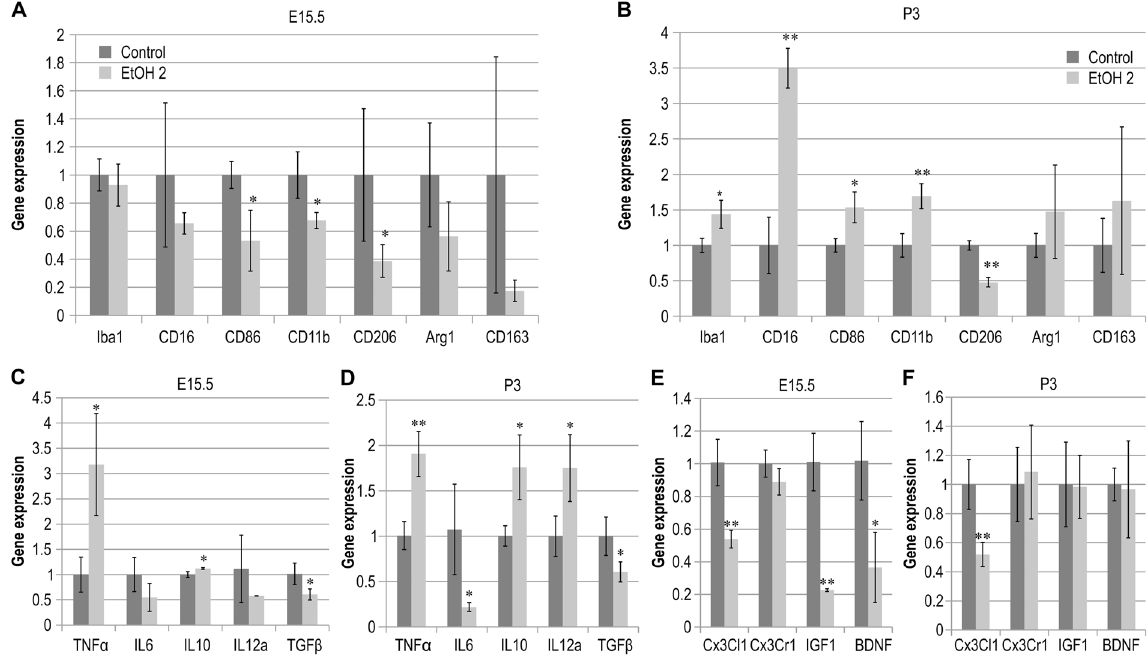
Figure 4. Disrupted mRNA expression of microglial markers, cytokines, and neurotrophic factors. Altered mRNA expression was observed in the embryonic dorsal telencephalon and prefrontal cortex of mice prenatally exposed to 2.0 g∙kg − 1 EtOH (n = 6, respectively). ( A , B ) Graphs depicting expression of Iba1, CD16, CD86, CD11b, CD206, Arg1 , and CD163 mRNA in the dorsal telencephalon or prefrontal cortex at E15.5 ( A ) and P3 ( B ). ( C , D ) Graph depicting the expression of TNF α , IL6 , IL10, IL12a , and TGF β mRNA at E15.5 ( C ) and P3 ( D ) in the dorsal telencephalon and prefrontal cortex, respectively. ( E , F ) Graph depicting the expression of Cx3Cl1 , Cx3Cr1, IGF1 , and BDNF mRNA expression in the dorsal telencephalon and prefrontal cortex at E15.5 ( E ) and P3 ( F ), respectively. * P < 0.05, ** P < 0.01 compared to 0 g∙kg − 1 controls using Student’s t-test or Aspin- Welch’s